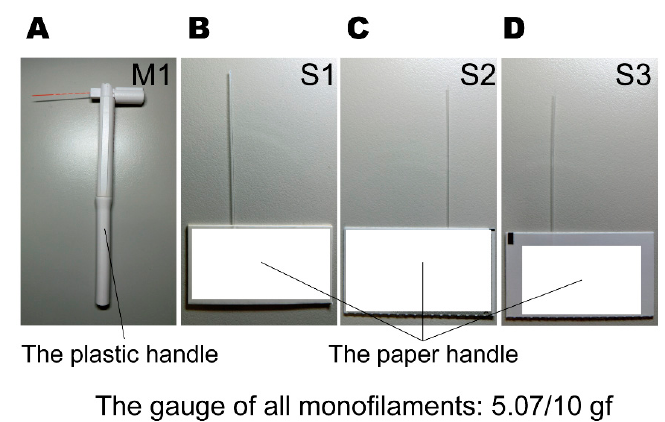
Figure 2. The total four 5.07/10 gf monofilaments: ( A ) the multi-use monofilament (M1); ( B , C , D ) the single-use monofilaments (S1, S2, and S3).